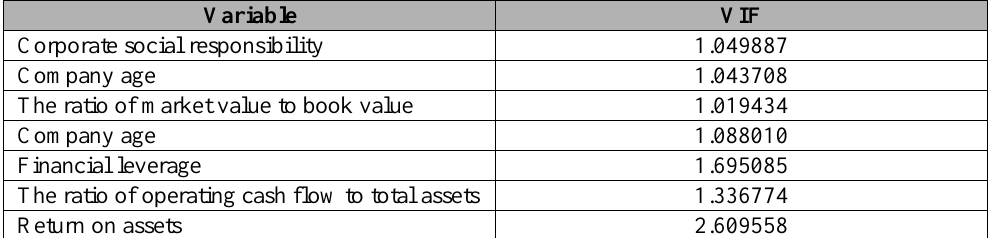
Table 5. Variance Inflation Factor of the first research model